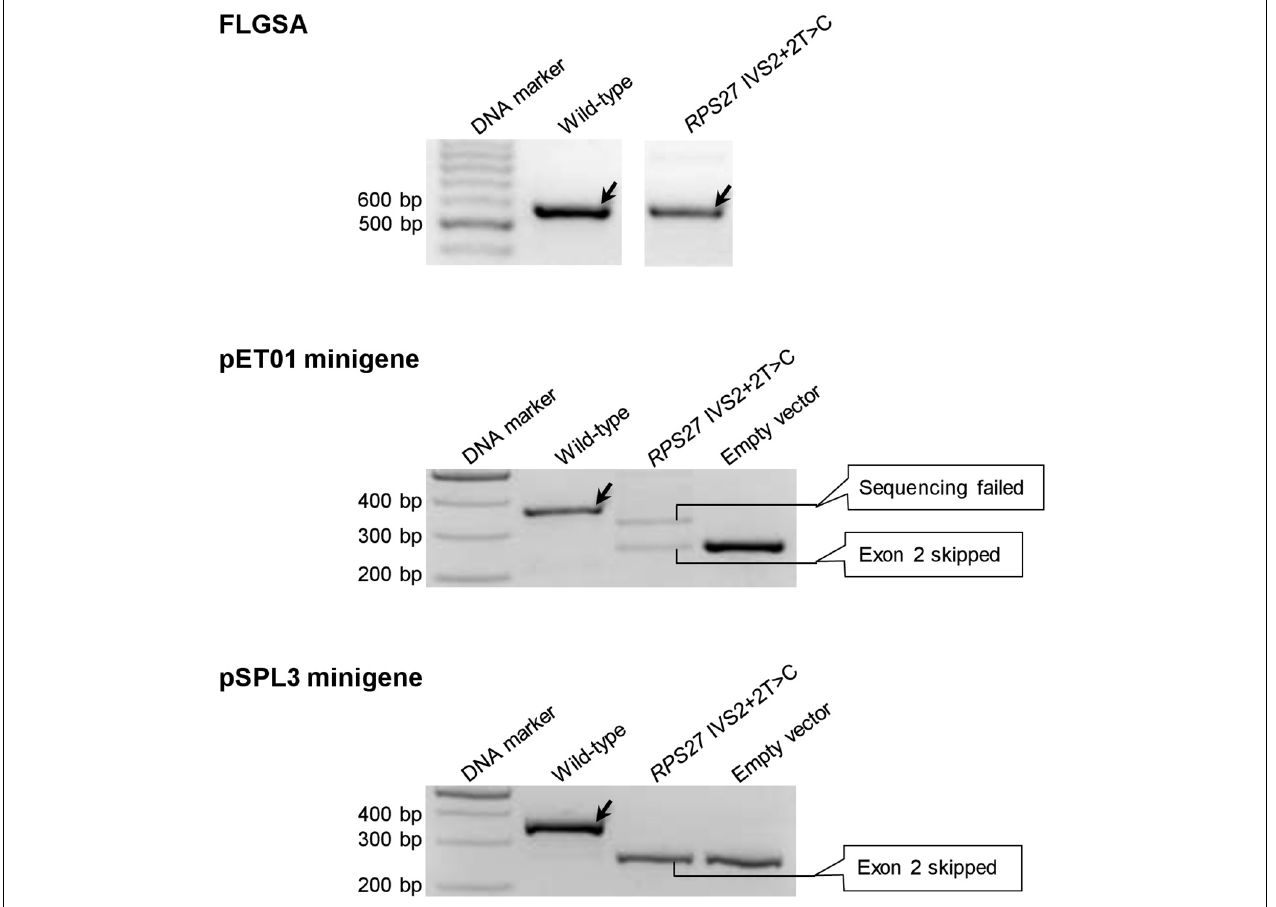
FIGURE 5 | Reverse transcription-polymerase chain reaction results from the pET01 and pSPL3 minigene assays with respect to the RPS27 IVS2+2T > C variant. Results from the previously performed full-length gene splicing assay (FLGSA) (Lin et al., 2019) are included for the sake of comparison. In all panels, wild-type transcripts are indicated by oblique downward pointing arrows. See Supplementary Figure 17 for the full gel photographs with respect to the minigene assays. The FLGSA data were adapted from Lin et al. (2019) with permission (Copyright 2020 Wiley Periodicals